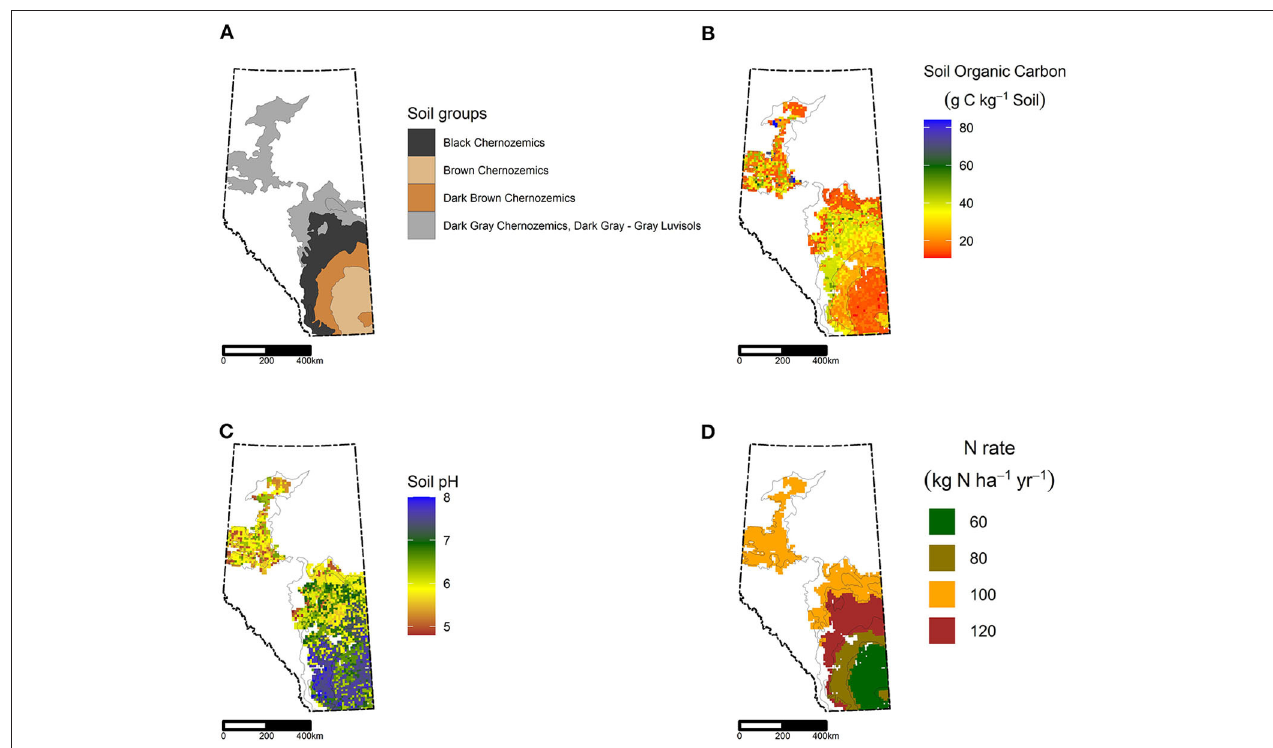
FIGURE 2 | (A) Spatial distribution of the soil groups comprising the agricultural zone of Alberta, which represents the study area for ecosys simulation. (B) Spatial distribution of top soil (0–15cm) organic carbon contents, and (C) pH of the agricultural zone of Alberta that was simulated in this study. (D) Spatial distribution of typical fertilizer nitrogen application rates used in ecosys simulations. The white areas on the map were not modeled based on the selection criteria as described in section Methodology and Model Inputs. The thick dashed lines on the maps represent Alberta’s provincial boundary, and the thin black lines within the maps demarcate soil group